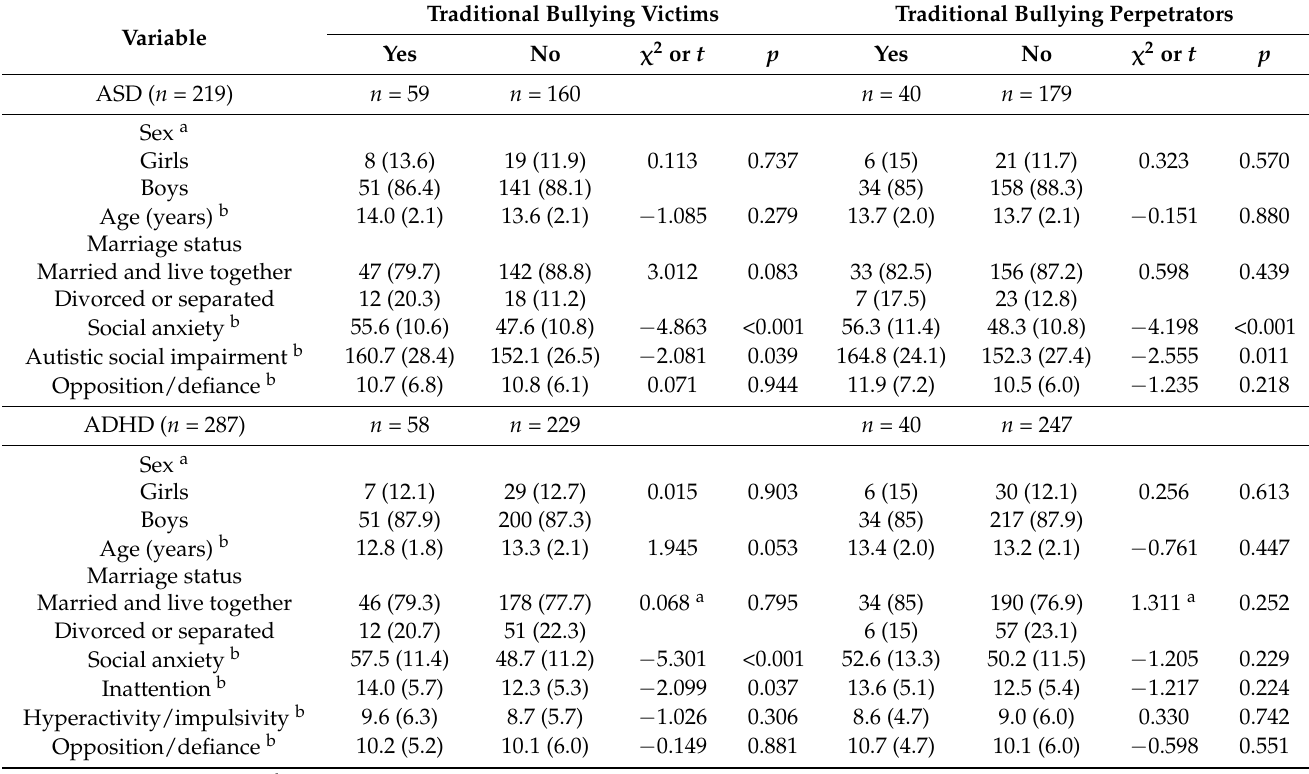
Table 3. Comparisons of Demographic Characteristics, Autistic Social Impairment, ADHD and Oppositional Defiant Symptoms, and Social Anxiety Between Adolescents Involved and Not Involved in Traditional Bullying: Chi-squared and t